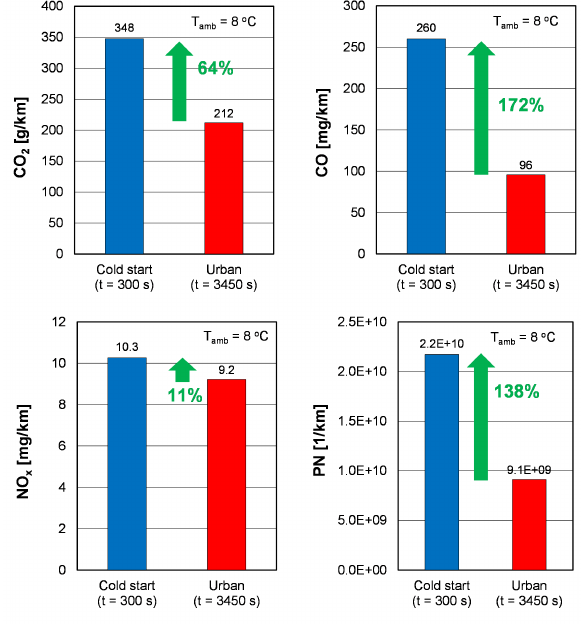
Figure 9: The on-road emissions of carbon dioxide, carbon monox- ide, nitrogen oxides, and particles number during the cold start for an ambient temperature of 25 ∘ C